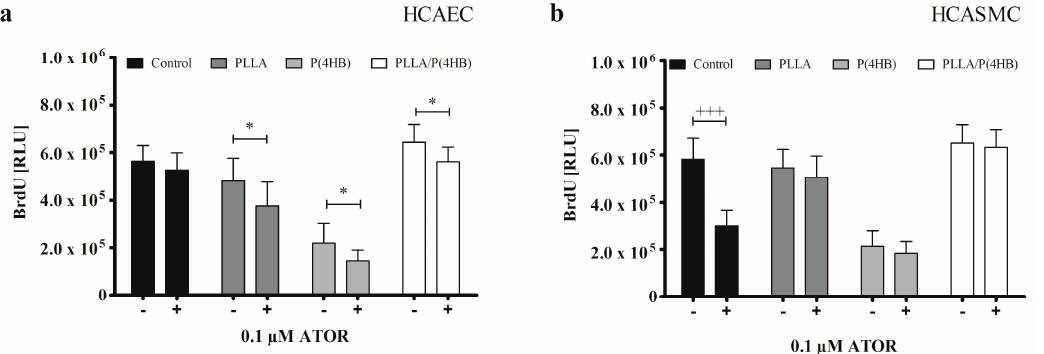
Figure 3. Polymers attenuate anti-proliferative actions of ATOR on SMCs. ( a ) HCAEC were cultured on polymer surfaces in the absence of ATOR ( − ) or presence of 0.1 µM ATOR for 48 h (+); ( b ) HCASMC were cultured on polymer surfaces and treated for 48 h with 0.1 µM ATOR (+). Proliferation was determined after BrdU incorporation. Bars show mean ± SD of three independent experiments with * p < 0.05 compared to the corresponding HCAEC control and +++ p < 0.001 compared to the HCASMC control.